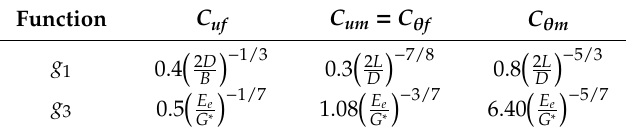
Table 1. Influence factors for a single suction pile.